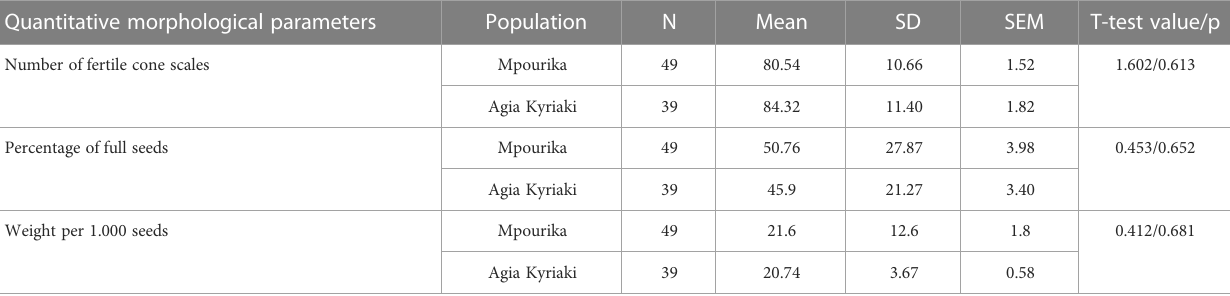
Quantitative morphological